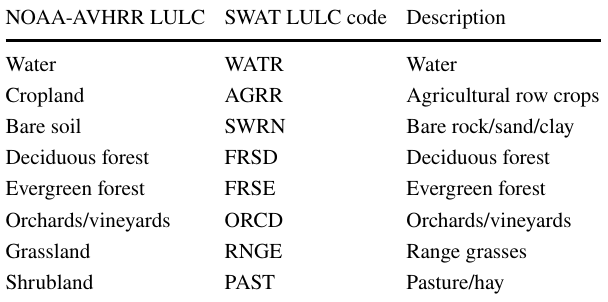
Fig. 3 Elevation zone map of the